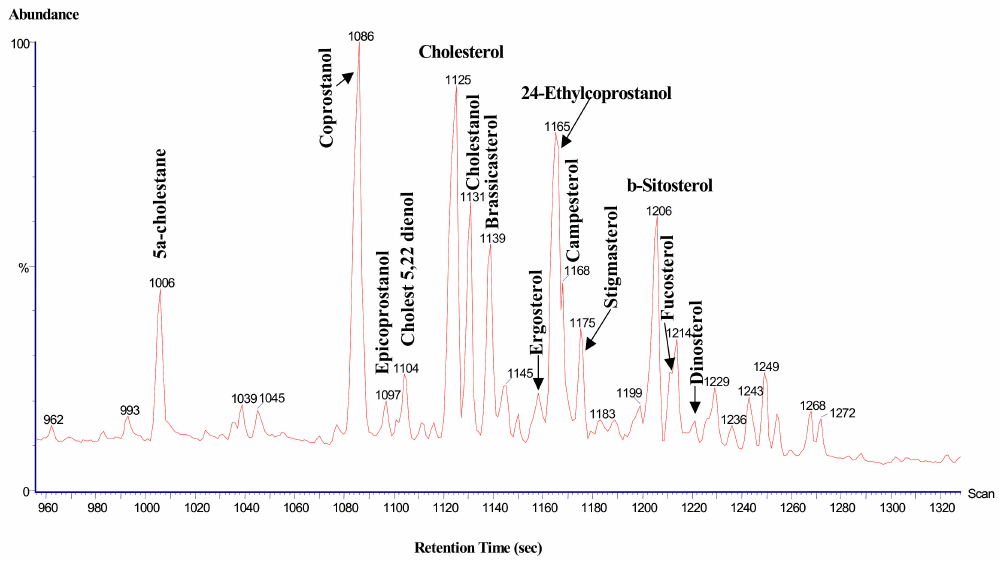
Figure 3. Full scan GCMS total ion chromatogram showing sterols detected in a sediment sample collected from Salcott Creek, next to the sewage works outlet